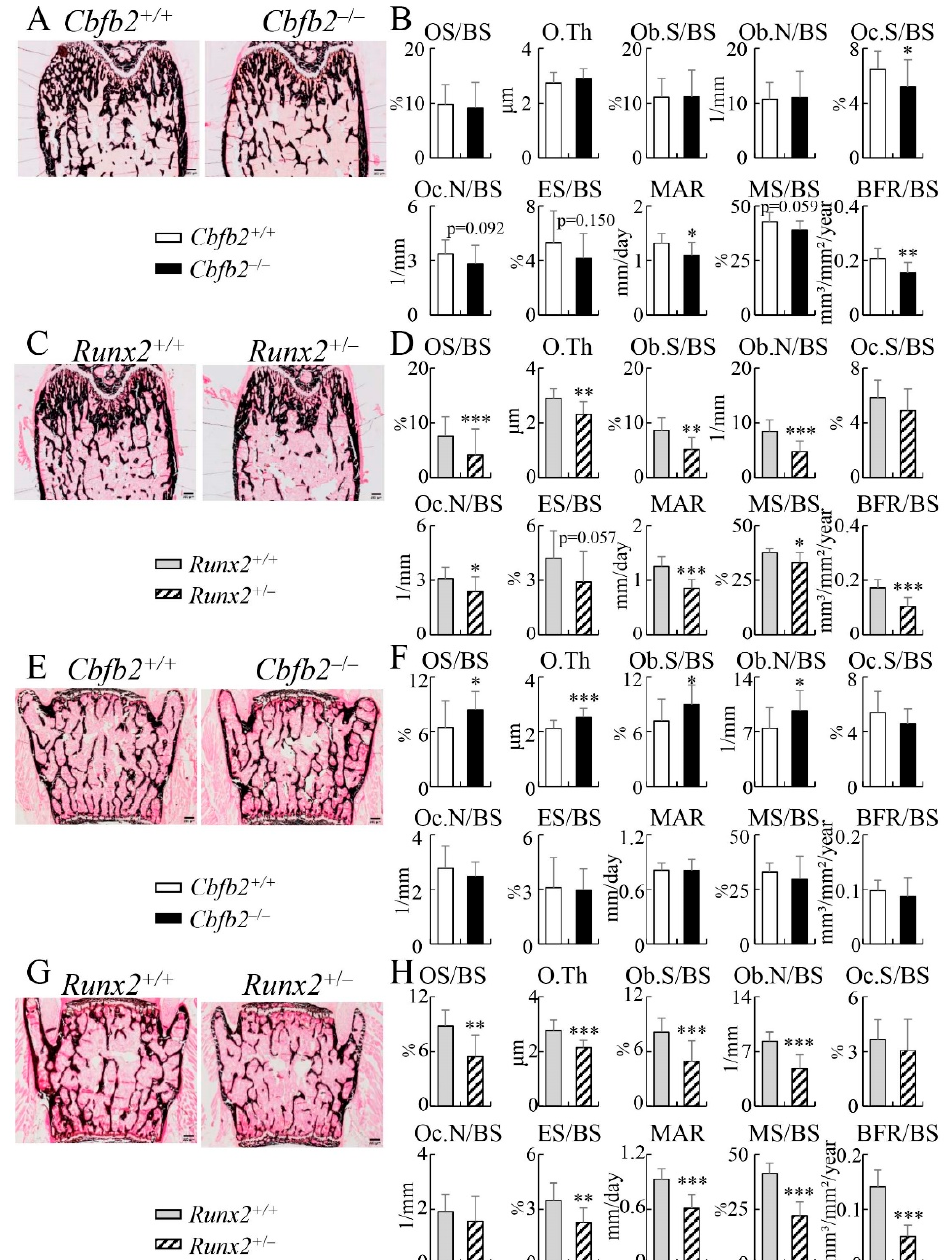
Figure 12. Bone histomorphometric analyses of trabecular bone in femurs and vertebrae in male mice at 10 weeks of age. ( A – D ) Bone histomorphometric analysis of femurs in Cbfb2 +/+ and Cbfb2 –/– mice ( A , B ) and Runx2 +/+ and Runx2 +/– mice ( C , D ). The osteoid surface (OS/BS), osteoid thickness (O.Th), osteoblast surface (Ob.S/BS), number of osteoblasts (N.Ob/BS), osteoclast surface (Oc.S/BS), number of osteoclasts (N.Oc/BS), eroded surface (ES/BS), mineral apposition rate (MAR), mineralizing surface (MS/BS) and bone formation rate (BFR/BS) are shown. BS, bone surface. The number of mice analyzed: Cbfb2 +/+ , n = 18; Cbfb2 –/– , n = 14; Runx2 +/+ , n = 10; Runx2 +/– , n = 14. ( E – H ) Bone histomorphometric analyses of lumbar vertebrae in Cbfb2 +/+ and Cbfb2 –/– mice ( E , F ) and Runx2 +/+ and Runx2 +/– mice ( G , H ). Scale bars: 0.2 mm. Data are shown as the mean ± SD. * p < 0.05, ** p < 0.01 and *** p < 0.001. The number of mice analyzed: Cbfb2 +/+ , n = 19; Cbfb2 –/– , n = 14; Runx2 +/+ , n = 10; Runx2 +/– , n = 11.